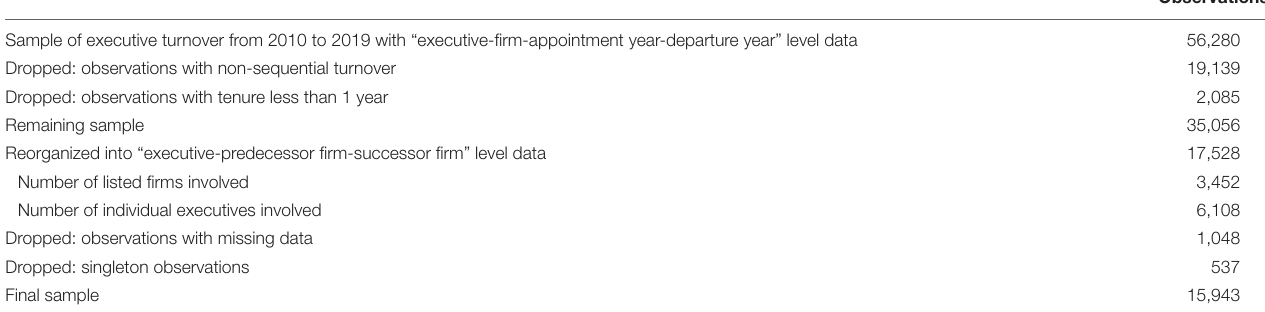
TABLE 1 | Sample selection